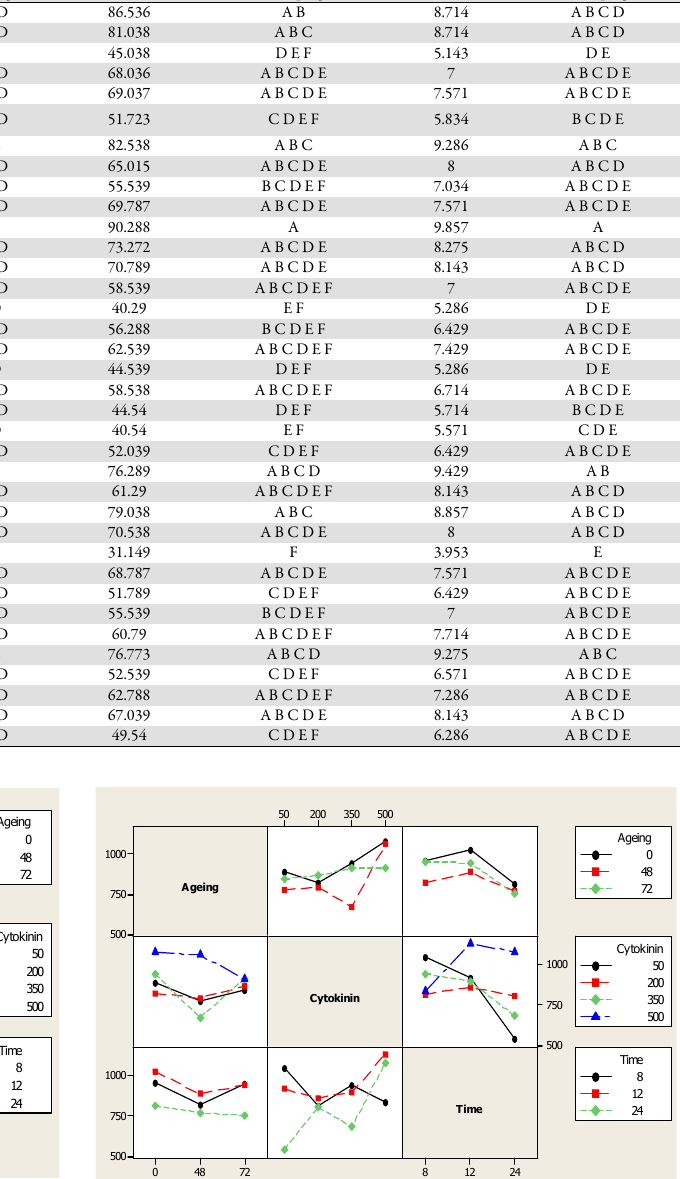
Fig. 6. Interaction plot of vigor index under hormone seed priming and ageing treatments